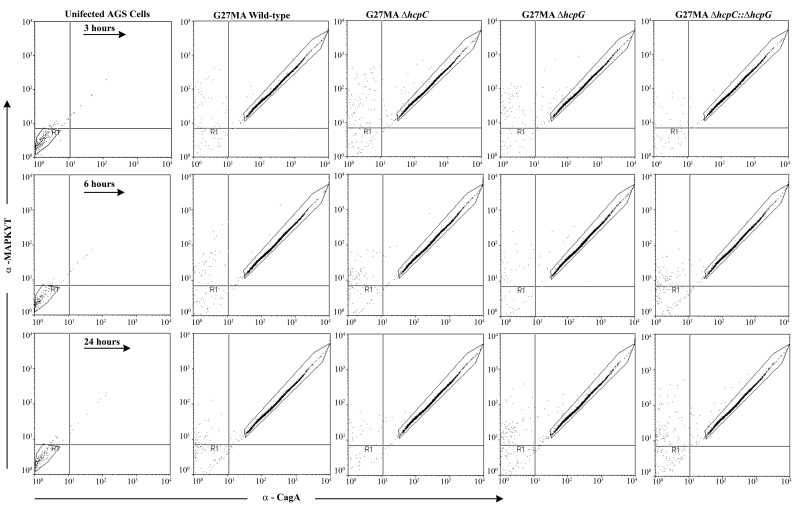
Deletion of hcpG and/or hcpC does not alter independent infection-induced signaling events.CagA and activated MAPK (ERK2) expression in hcp mutants, WT G27MA and uninfected AGS cells over the course of infection. A shift in the fluorescence to the upper right quadrant in AGS cells infected with either WT or hcpC or hcpG mutants compared with uninfected AGS cells indicates increased CagA and activated-MAPK expression after infection. Results are representative of three experiments.